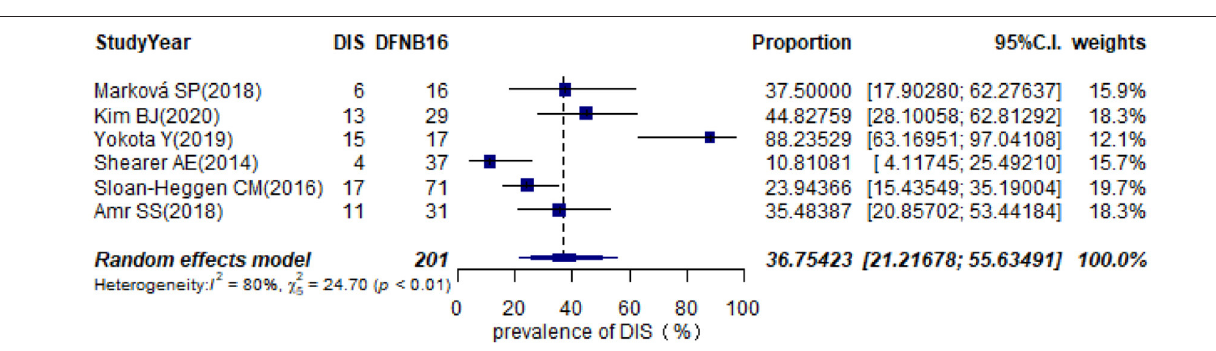
FIGURE 7 | Prevalence of deafness–infertility syndrome (DIS) in